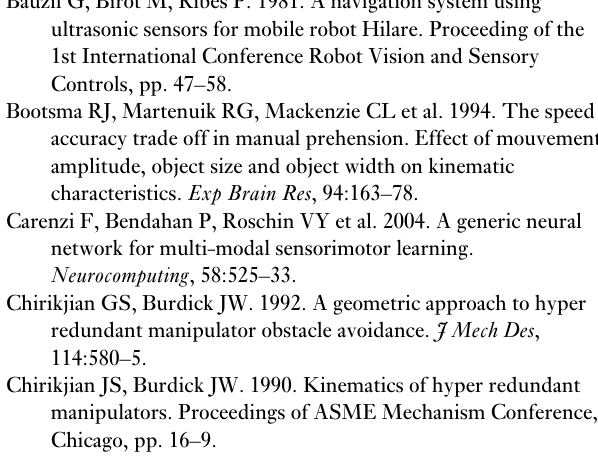
Figure 19 Modelisation